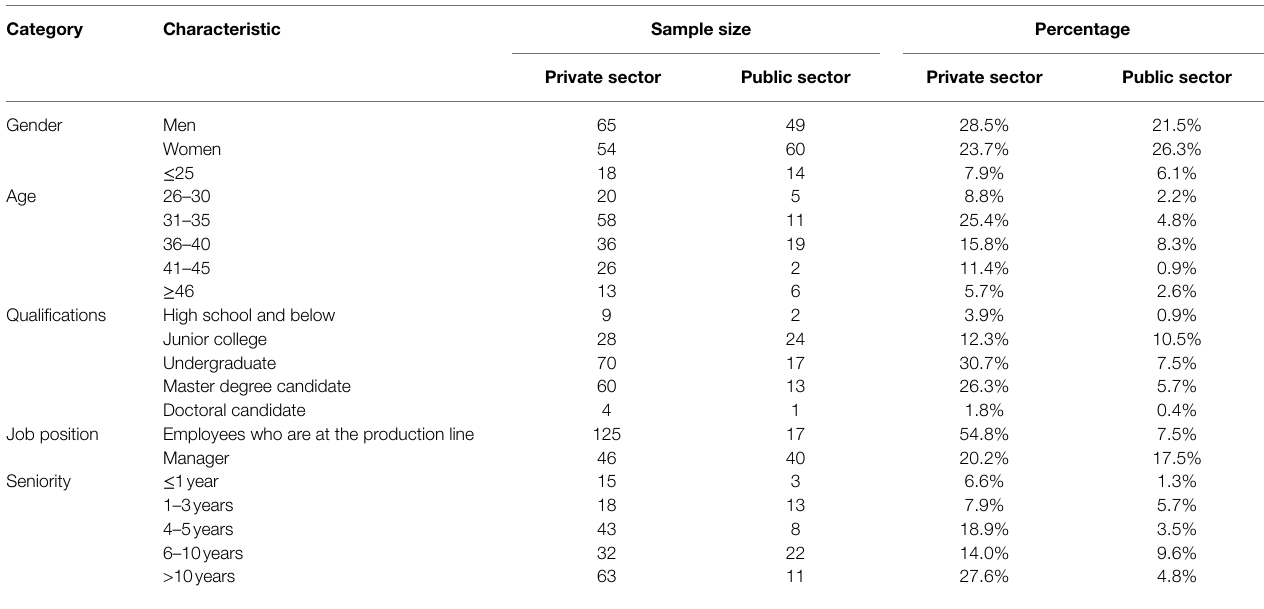
TABLE 1 | Structure of the samples ( N =